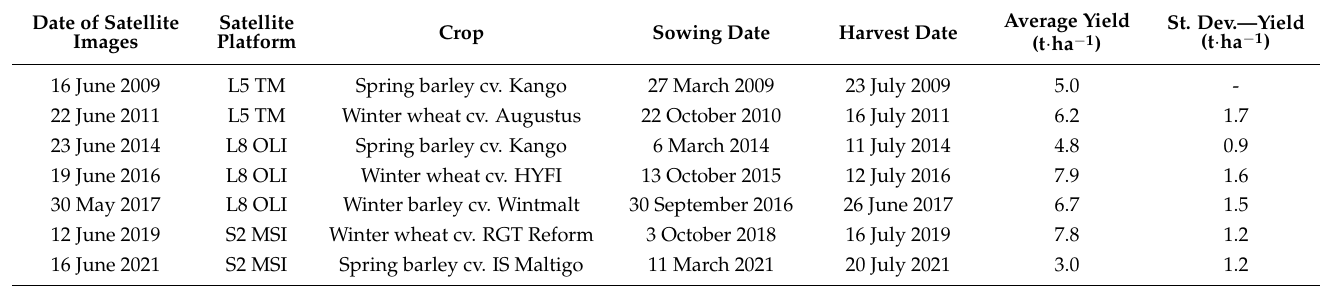
Table 2. Overview of satellite images with information about crops (crop, variety, sowing date, harvest date and average yield in t · ha − 1 with standard